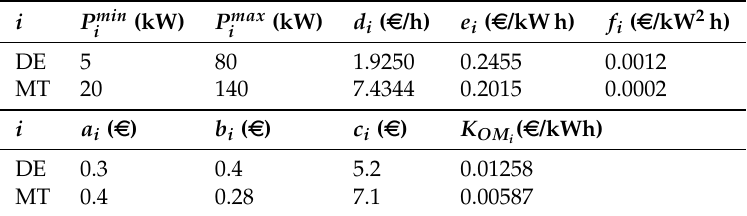
Table 2. Characteristic parameters of each of the generators considered in the